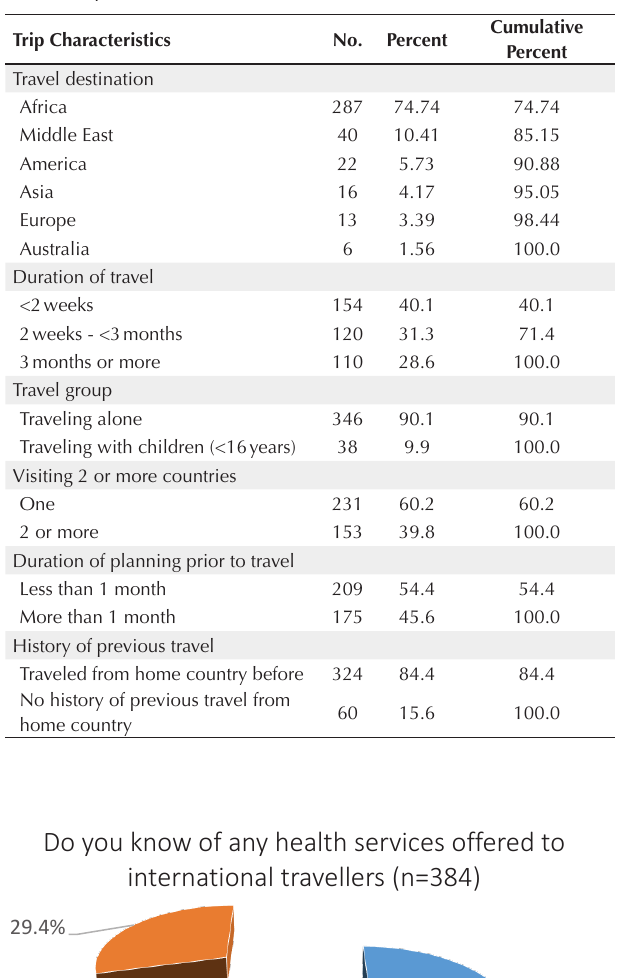
Table 1. Individual Characteristics of Respondents Table 2. Trip Characteristics